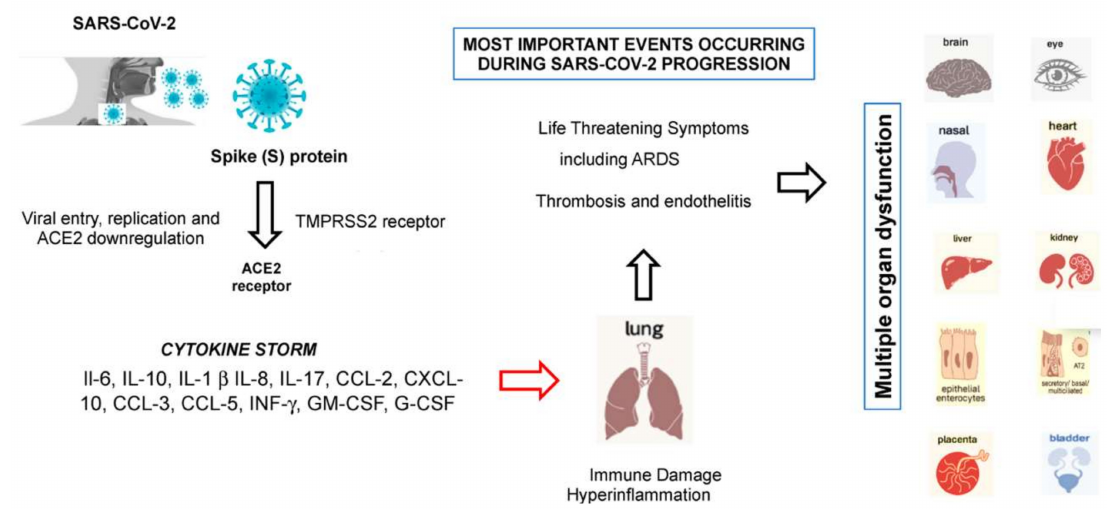
Figure 4. SARS-CoV-2 infection. Angiotensin-converting enzyme 2 (ACE2) expression is also found in respiratory and pulmonary tract cells (alveolar monocytes and macrophages), with the possibility of severe acute respiratory distress syndrome (ARDS) and in heart, kidneys, brain, endothelium, and liver, in which organ failure and thromboembolism may